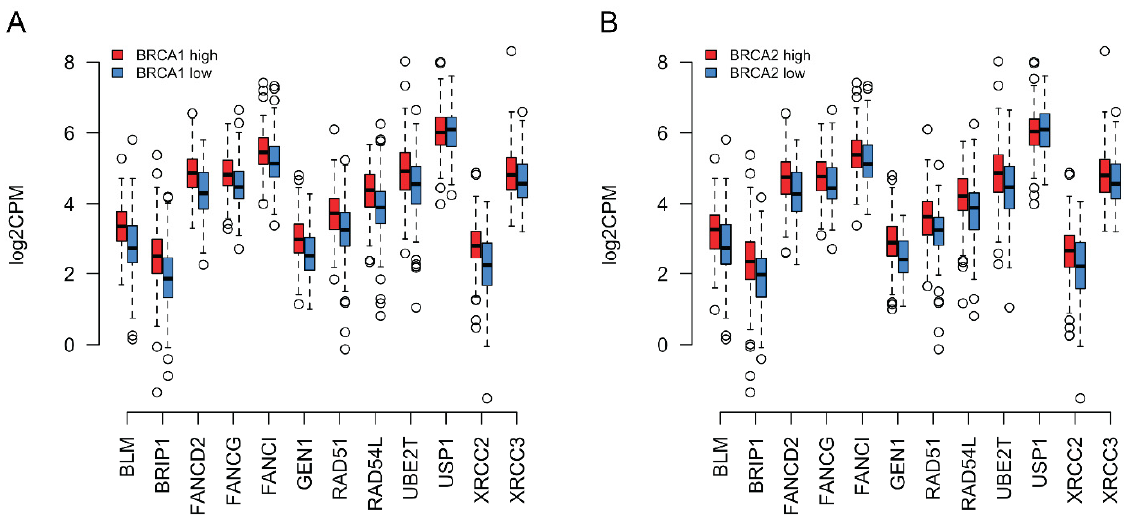
Figure 4. ( A ) RNA-seq expression values of a subset of HR genes (see legend to Figure 3) in log2 Counts Per Million (log2CPM) for ovarian cancer samples from the TCGA database. Median BRCA1 expression was calculated for the TCGA ovarian cancer samples. Samples where BRCA1 expression was equal to or above this median are depicted in red, whereas those where it was below this median are depicted in blue. The thick horizontal lines show the median. Again, the tumors with higher BRCA1 expression also tended to show higher expression of the other depicted genes. ( B ) Similar to ( A ) but classing the tumors based on BRCA2 expression instead.